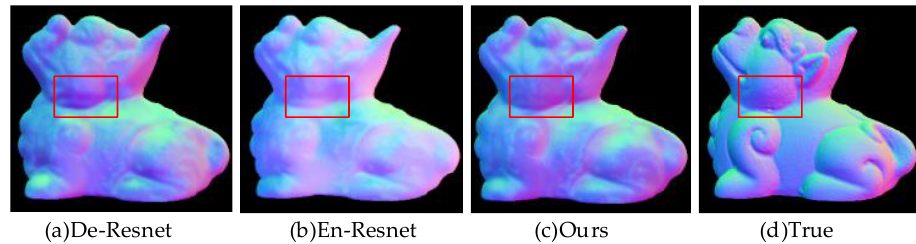
Figure 10. Resnet structure verification. The red boxes can be used to compare the differences in texture and color information brought by these three experiments.